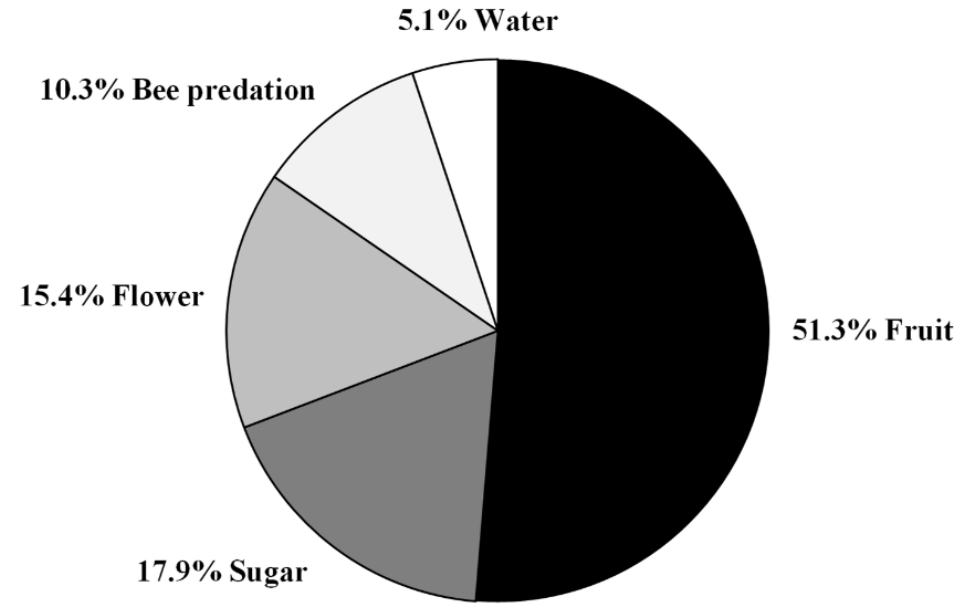
Figure 2. Relative frequency of European hornet foraging activity reports on ripe fruit, sugar exudates, flowers, water, and honey bees by citizen scientists.